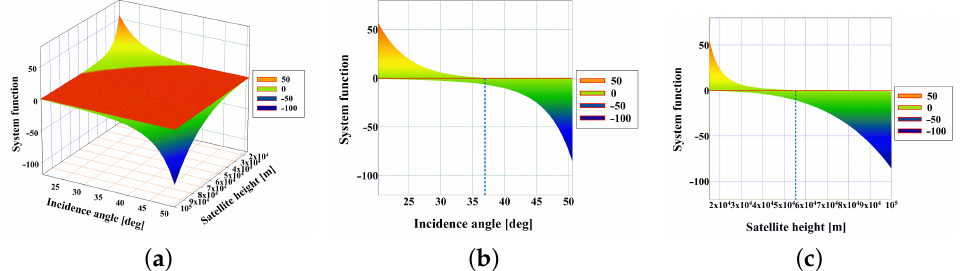
Figure 12. ( a ) When the average transmitting power, the number of multi-looks, and scale factor of water ice are P av = 6000 W, L look = 10 and 10%, the system function changes with the incidence angle φ and satellite height H sat . ( b , c ) are the simulation results of the system function varying with φ and H sat ,